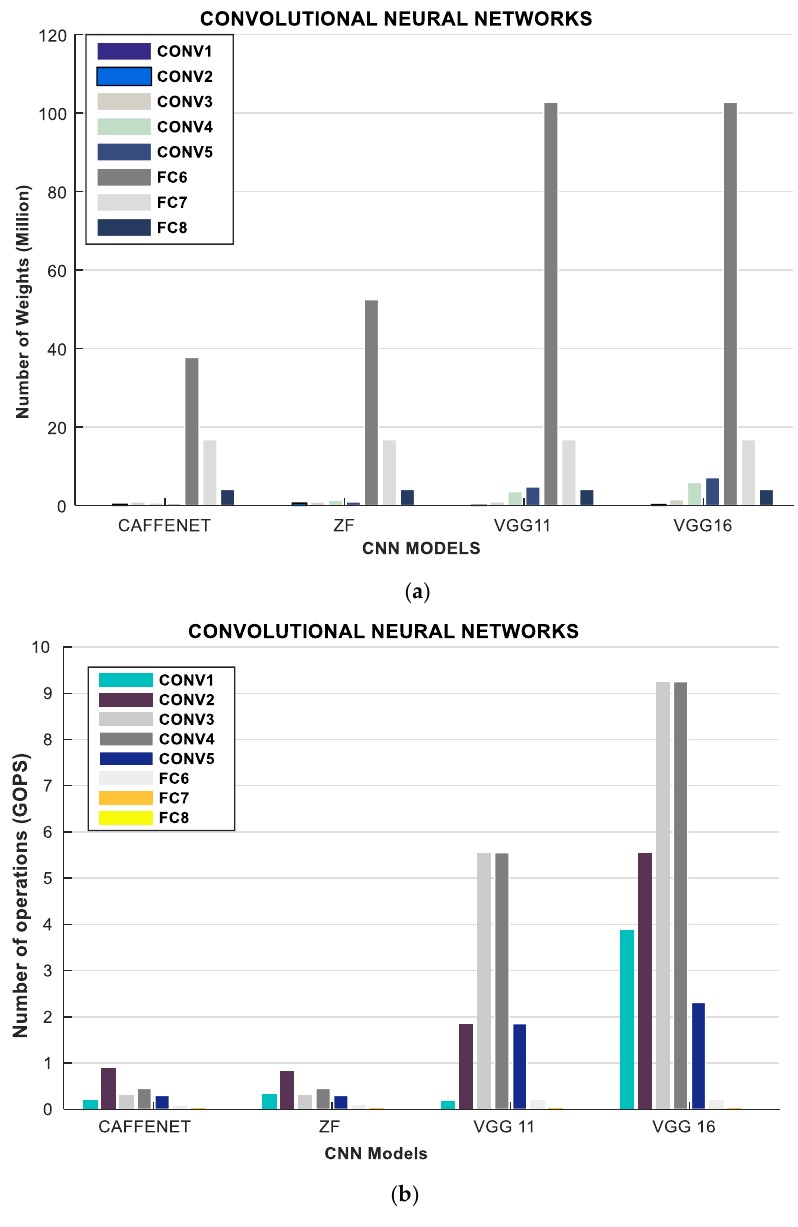
Figure 2. Description of a spectrum of certain CNN models to reveal their compute and memory demand: ( a ) Describes the Memory Demand of these models in terms of the number of weight parameters in (millions) ( b ) Computational Demand of these models in terms of their number of operations (GOPs). Table 10. Parameters for popular CNN models.